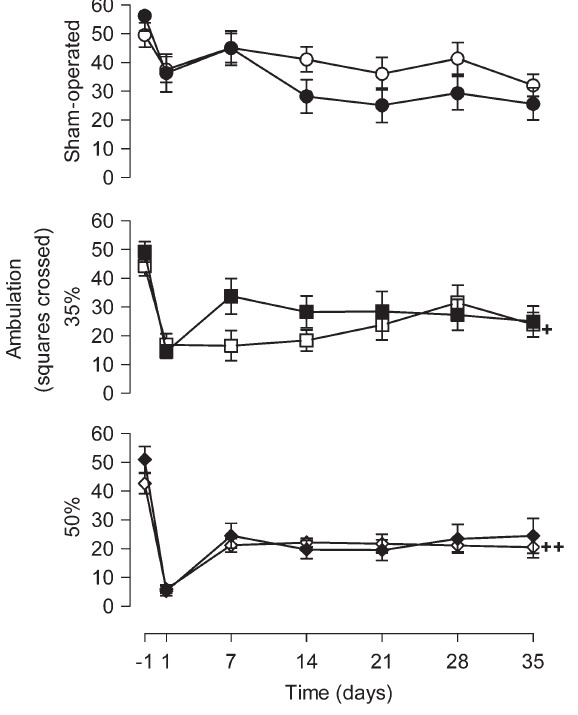
Figure 2. Melatonin treatment did not affect the ambulation of rats. Numbered squares crossed in an open arena were measured 24 h before (-1) and 1, 7, 14, 21, 28, and 35 days after narrowing of the spinal cord canal. Each point represents the mean ± SE for 9-11 rats. + P , 0.001 compared to sham- operated group from vehicle-treated animals, on days 1, 7 and 14 after narrowing of the spinal cord canal (ANOVA with the Duncan post hoc test). ++ P , 0.001 compared to sham-operated group from vehicle-treated animals, on days 1, 7, 14, and 28 after narrowing of the spinal cord canal and compared to 35% narrowing from vehicle-treated animals, on the first day after narrowing of the spinal cord canal (ANOVA with the Duncan post hoc test). Melatonin application did not change the number of floor units crossed by the animals of the three groups (MANOVA, P . 0.05). 35% = 35% narrowing group; 50% = 50% narrowing group. Open symbols = vehicle-treated groups; filled symbols =